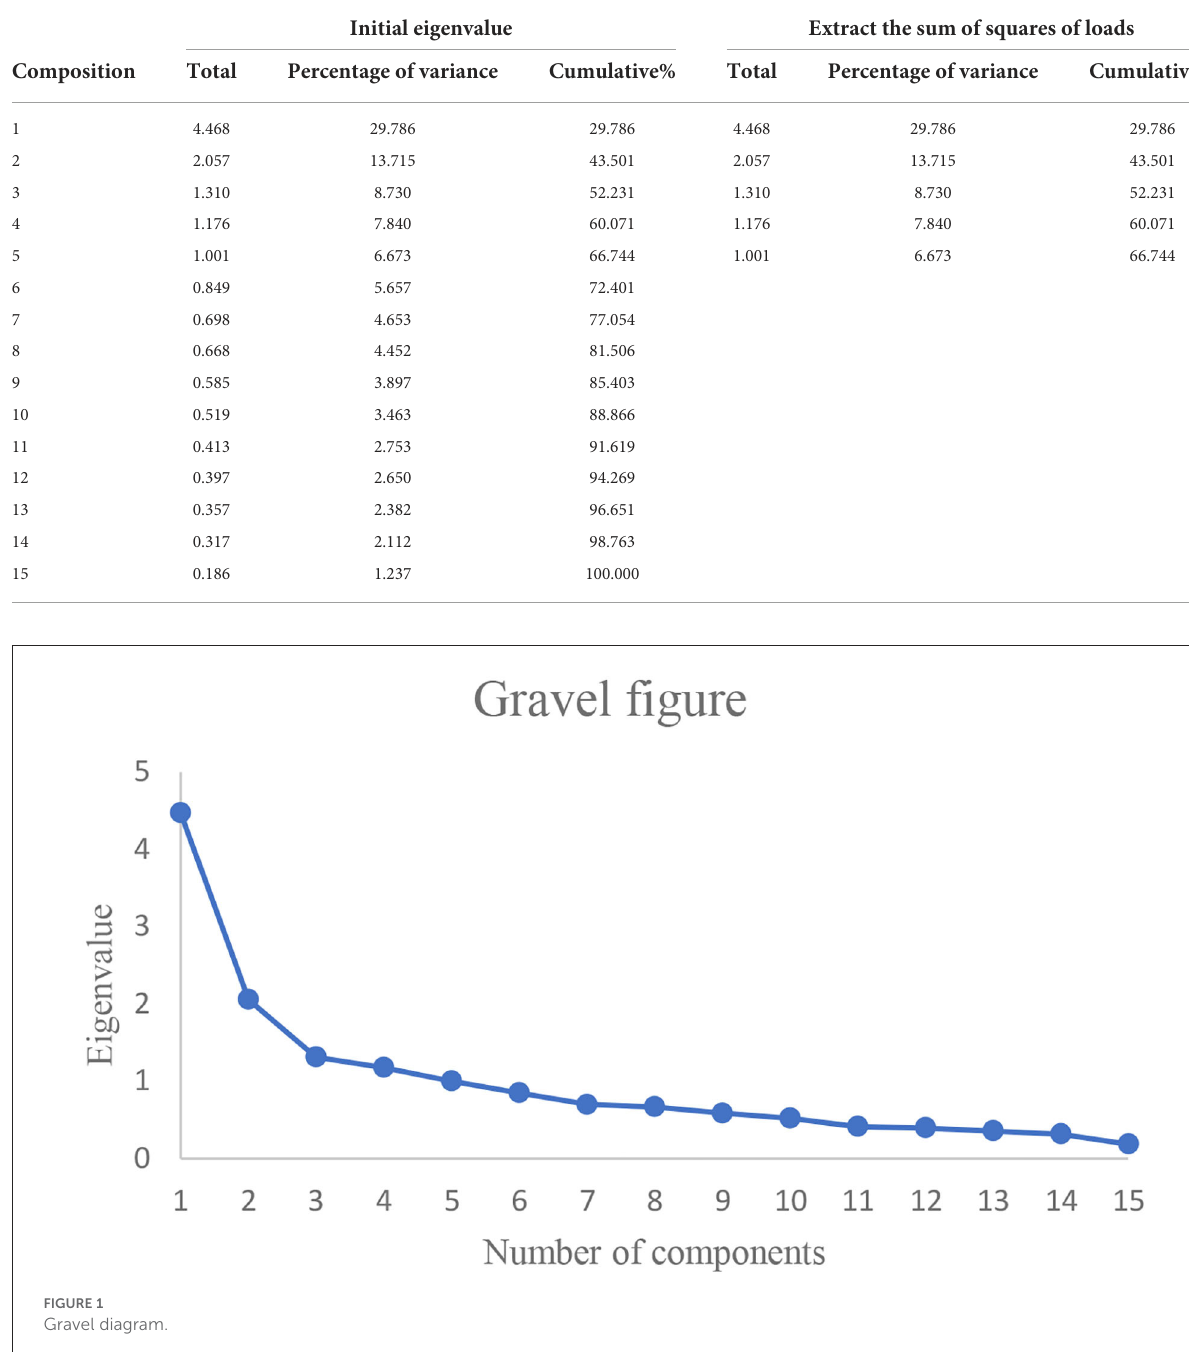
TABLE 5 Table of total variances.